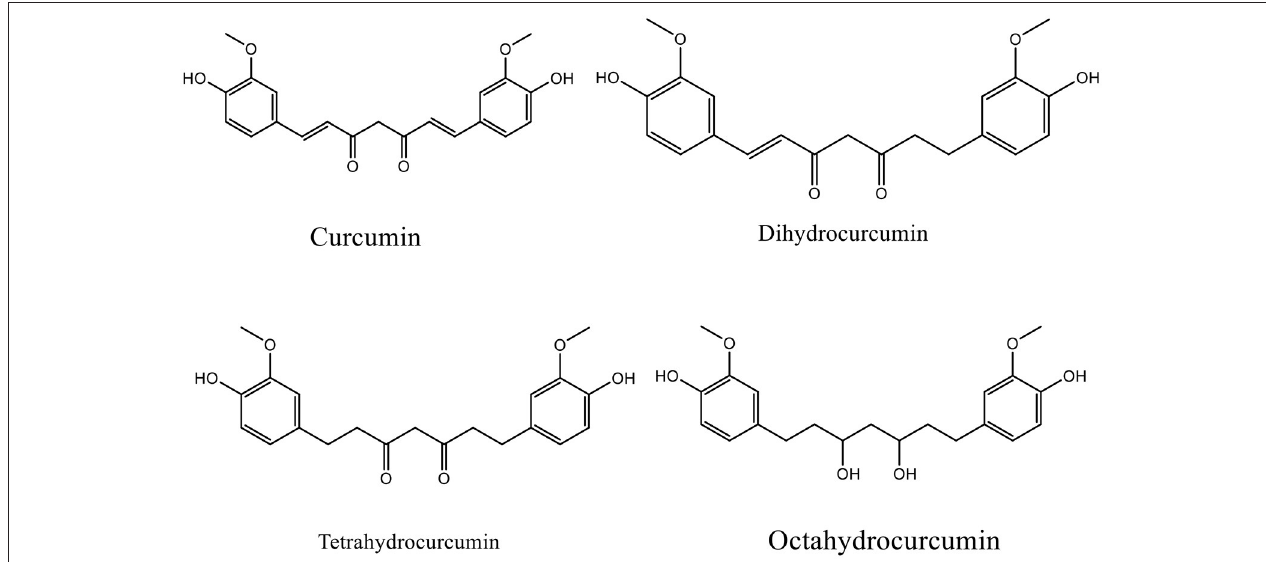
FIGURE 1 | Chemical structure of curcumin and its major